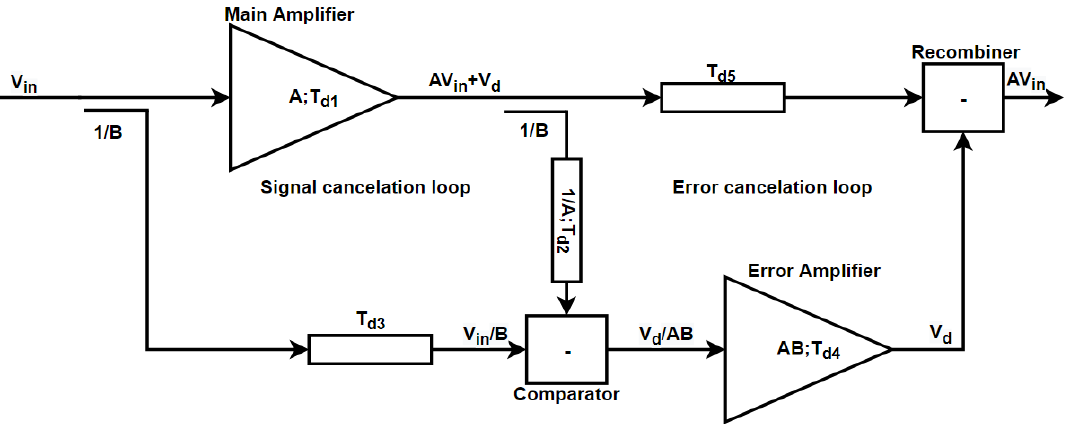
Figure 2. Simplified feedforward operational diagram.